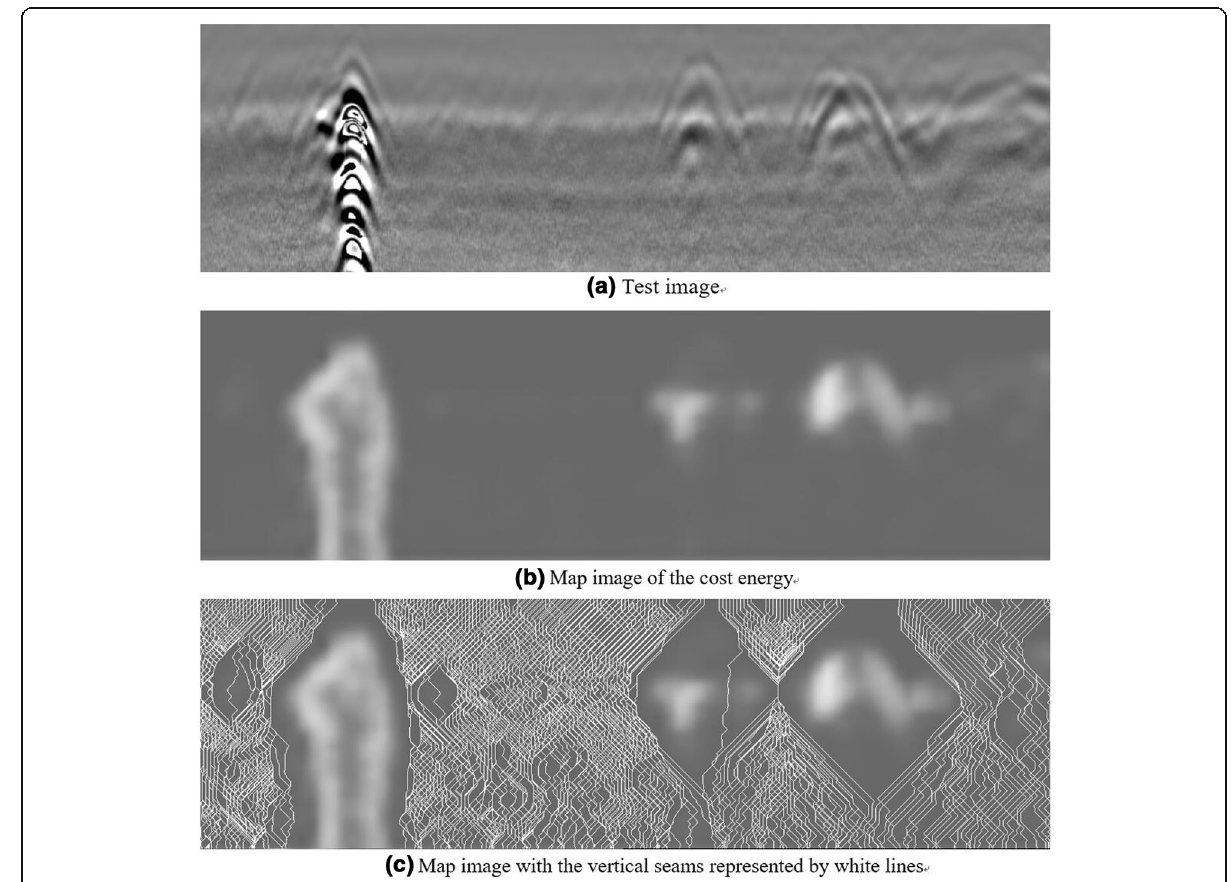
Fig. 5 a Test image. b Map image of the cost energy. c Map image with the vertical seams represented by white